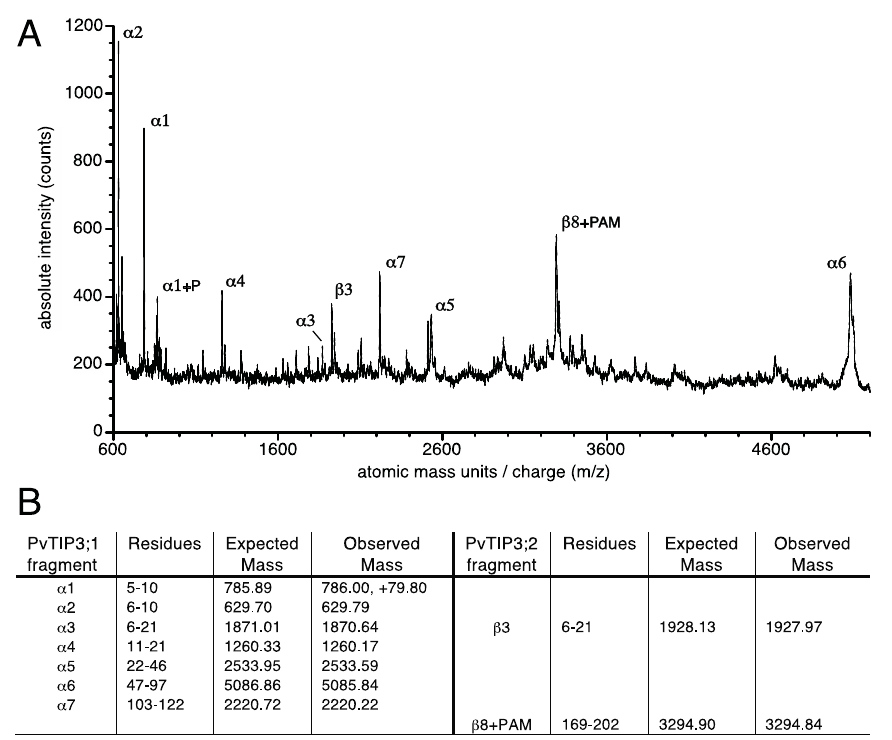
Figure 3. ( A ) MALDI-TOF MS of the trypsin-digested primary phosphoprotein from membranes of dry seed. ( B ) Mass predicted and observed for tryptic fragments of PvTIP3;1 and PvTIP3;2. P indicates